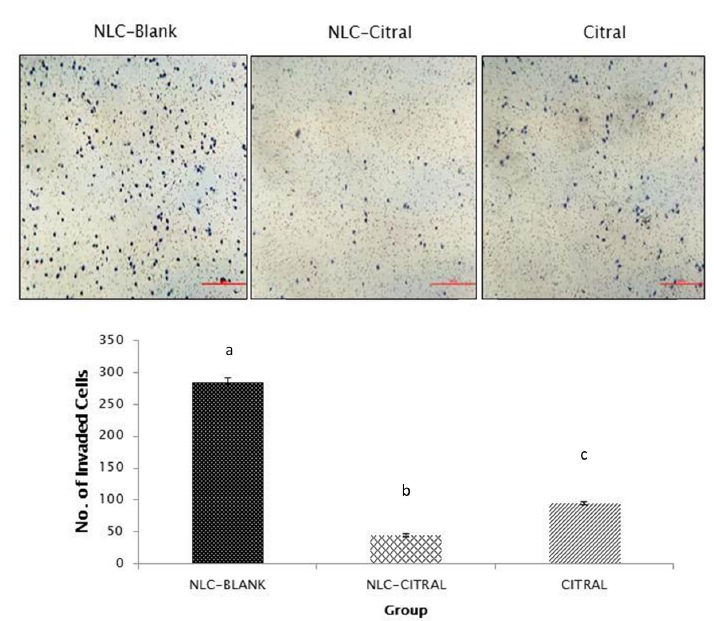
Figure 4. The representative images and bar chart analysis of invaded 4T1 cells through the transwell membrane after 24 h of treatment with 26 µg/mL (IC40) of NLC-Citral. The number of invaded cells was counted based on the presence of the blue dye stained cells. The images were viewed at 200 × magnification. Each value in the bar chart is represented as mean ± SD, the experiment was performed in triplicate. Significance indicated by different alphabet was set at p < 0.05 comparing between groups. The scale bars show 500 px (13.2 cm).